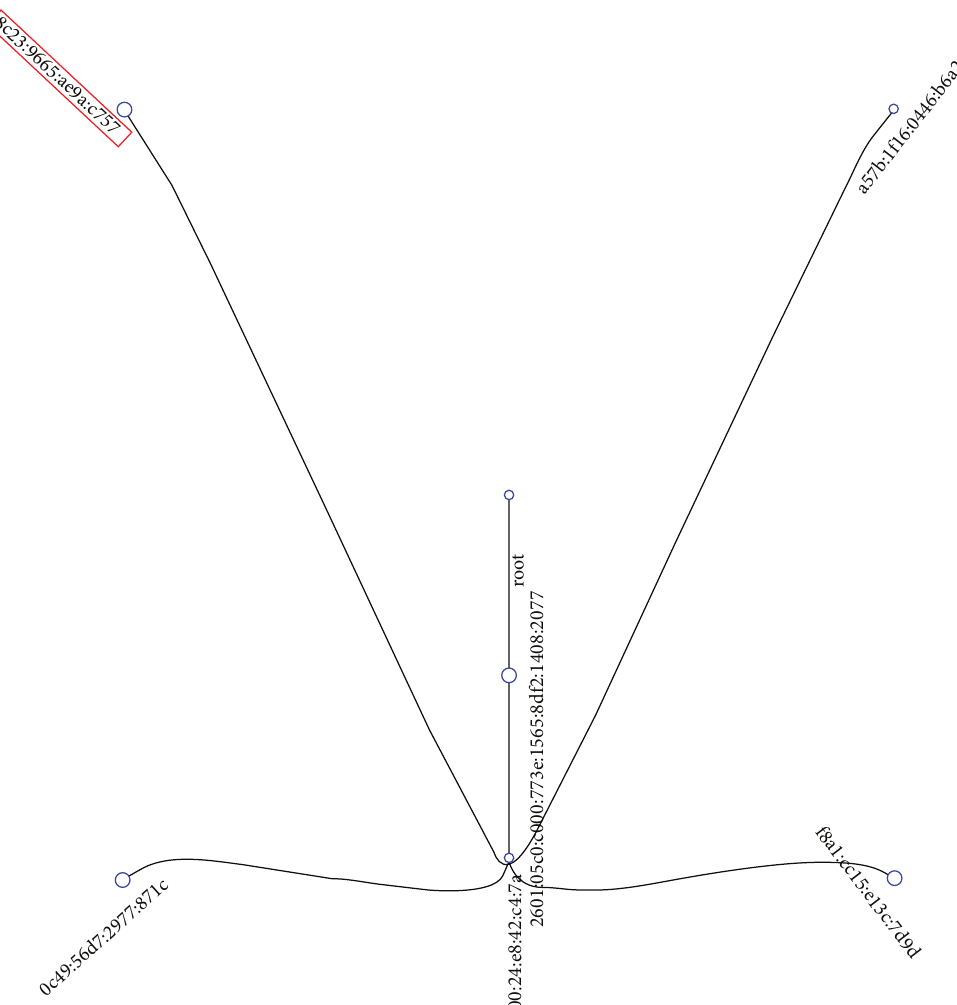
Figure 4: MT6D view depicting addresses spawned by a MT6D